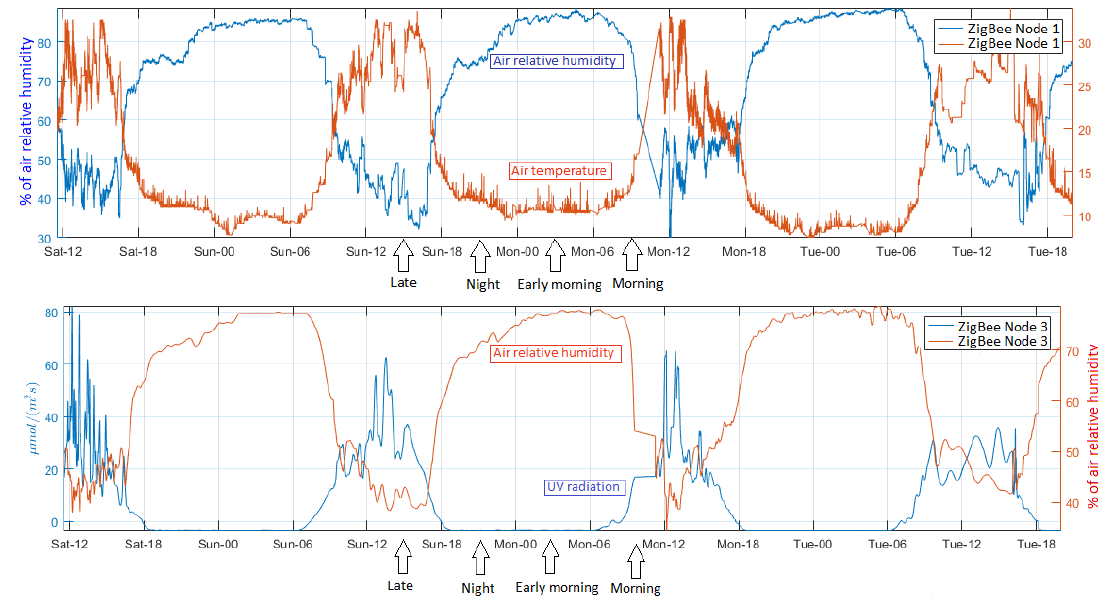
Figure 13. Temporal signals of the variables with direct and inverse relationship of the ZigBee network, from top to bottom.